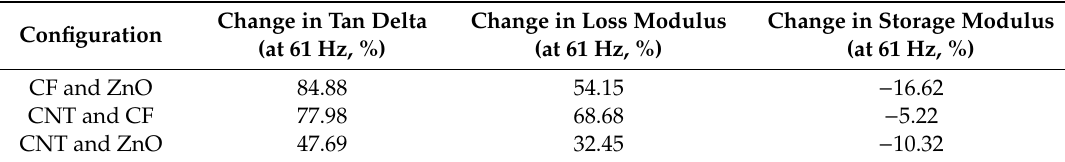
Table 3. Comparison of the viscoelastic performance of the various composite configurations with respect to a composite based on CF under frequency